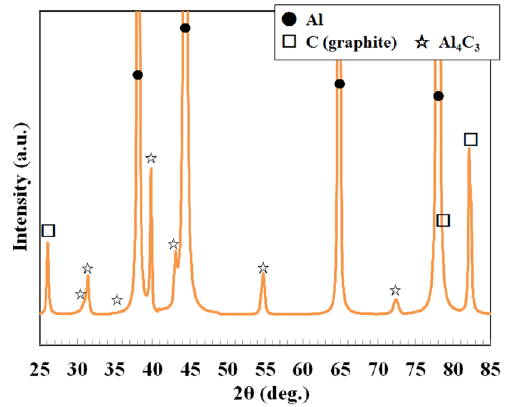
Figure 15. XRD pattern of Cu plated C/Al SLM composite.